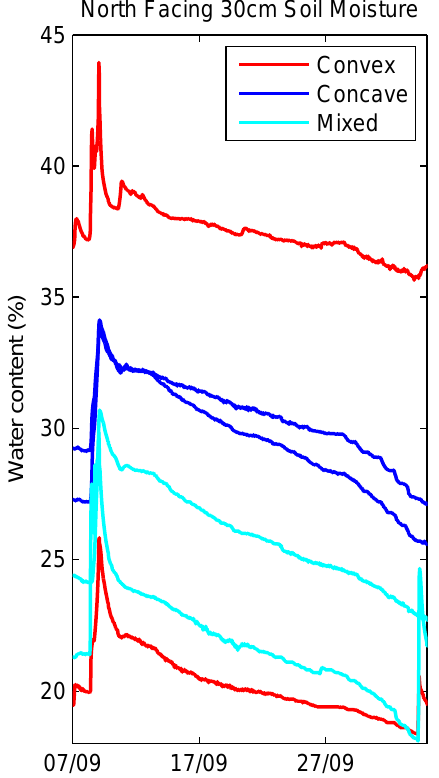
Figure 12. Selected north-facing 30cm soil moisture sensor re- sponses during a recession, having convex, concave or mixed re- sponse function